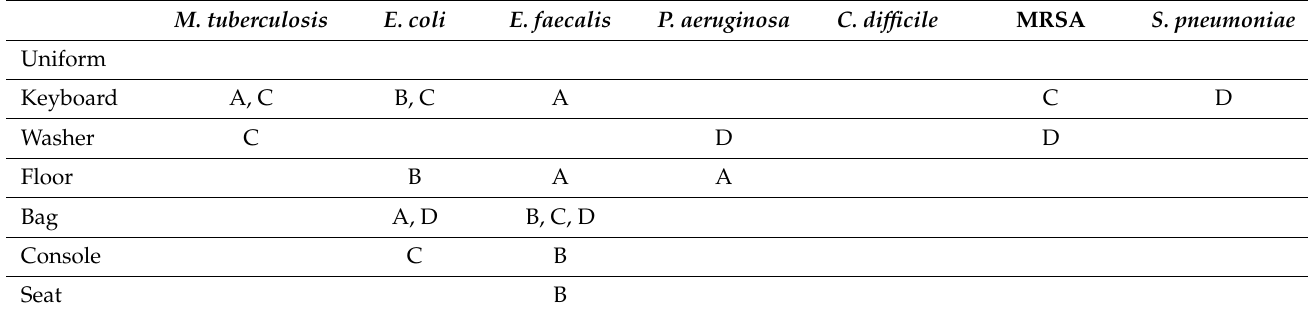
B Bacterial nucleic acid was detected in the visited fire stations on keyboards ( n = 13), on floors ( n = 10), and in washing machines ( n = 9); in the fire engines on medical bags ( n = 7), on consoles ( n = 6), and on seats ( n = 2); and on firefighter uniforms ( n = 3) (Tables 3 and 4). Comparisons using Tukey–Kramer HSD adjustments for multiple comparisons did not indicate significant differences in the occurrence of contamination between the surfaces, though keyboards were more likely to have bacteria detected, and uniforms, consoles, and seats were less likely to have bacteria detected (Table 5). Additionally, FD1 was more likely to have contaminated uniforms ( p = 0.0277). Table 5. Significance of the incidence of bacteria on surfaces at both FD. p -values were obtained using Tukey–Kramer HSD adjustments for multiple comparisons to determine if one type of surface was more likely to have bacteria than another. No statistical significance was found.